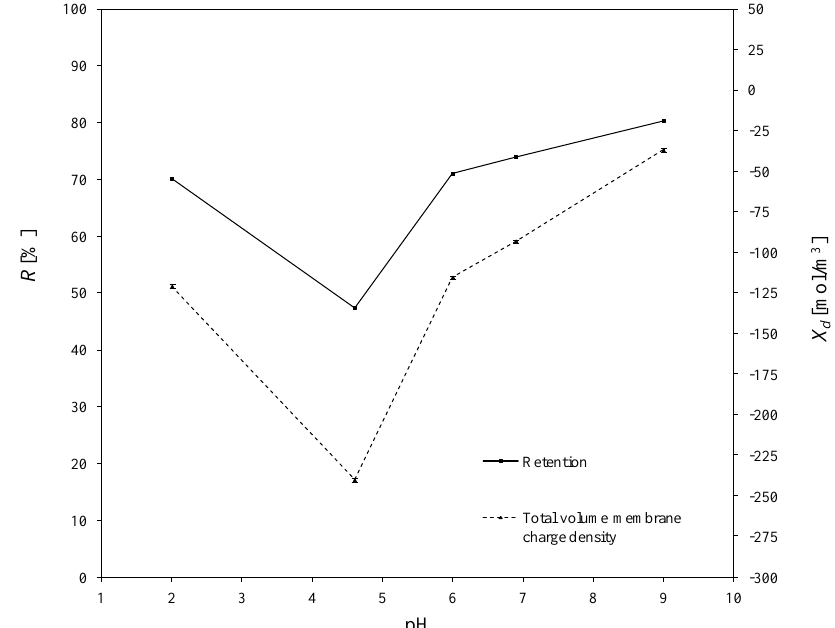
Figure 5. The influence of pH on the total volume charge density in aqueous solution of Fe(NO 3 ) 3 and the influence of pH on the (Fe 3+ ) retention. Retention values obtained experiments.